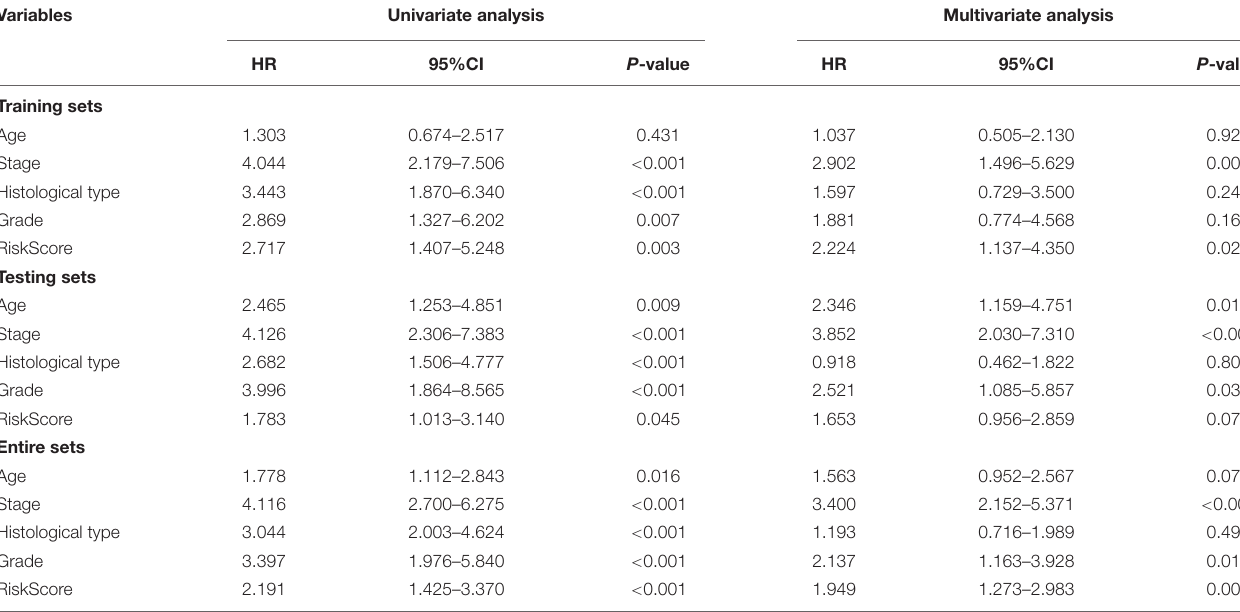
TABLE 2 | Univariate and multivariate Cox regression analyses of the prognosis-related